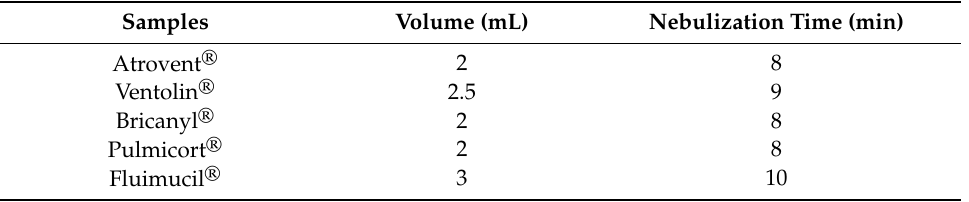
Table 1. Volume and nebulization times of all